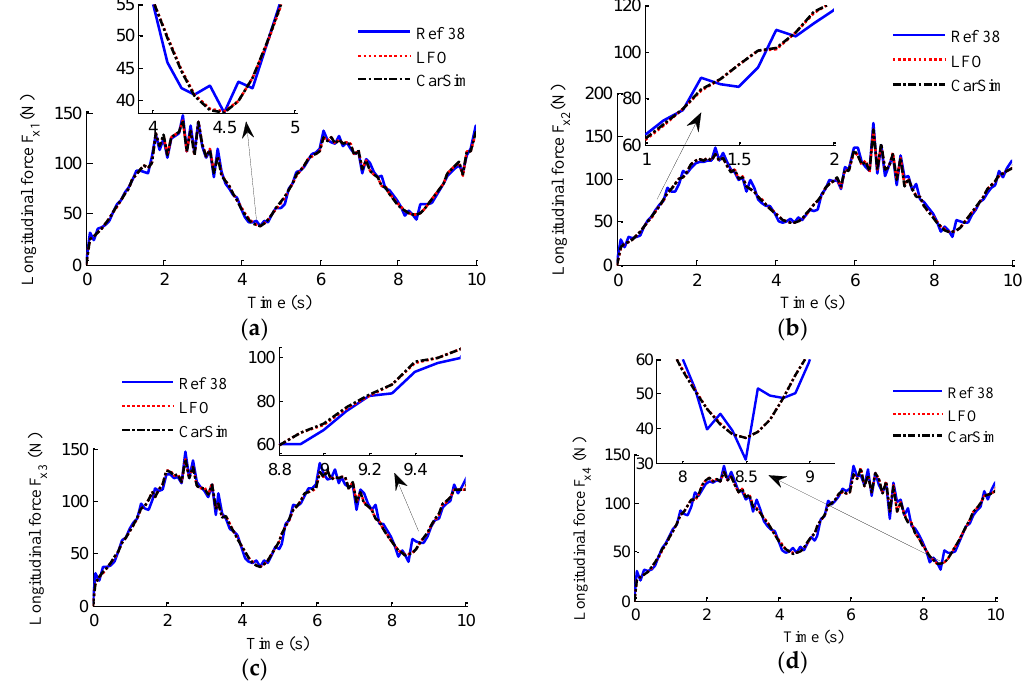
Figure 7. Estimation of longitudinal forces. ( a ) F x 1 ; ( b ) F x 2 ; ( c ) F x 3 ; ( d ) F x 4 .